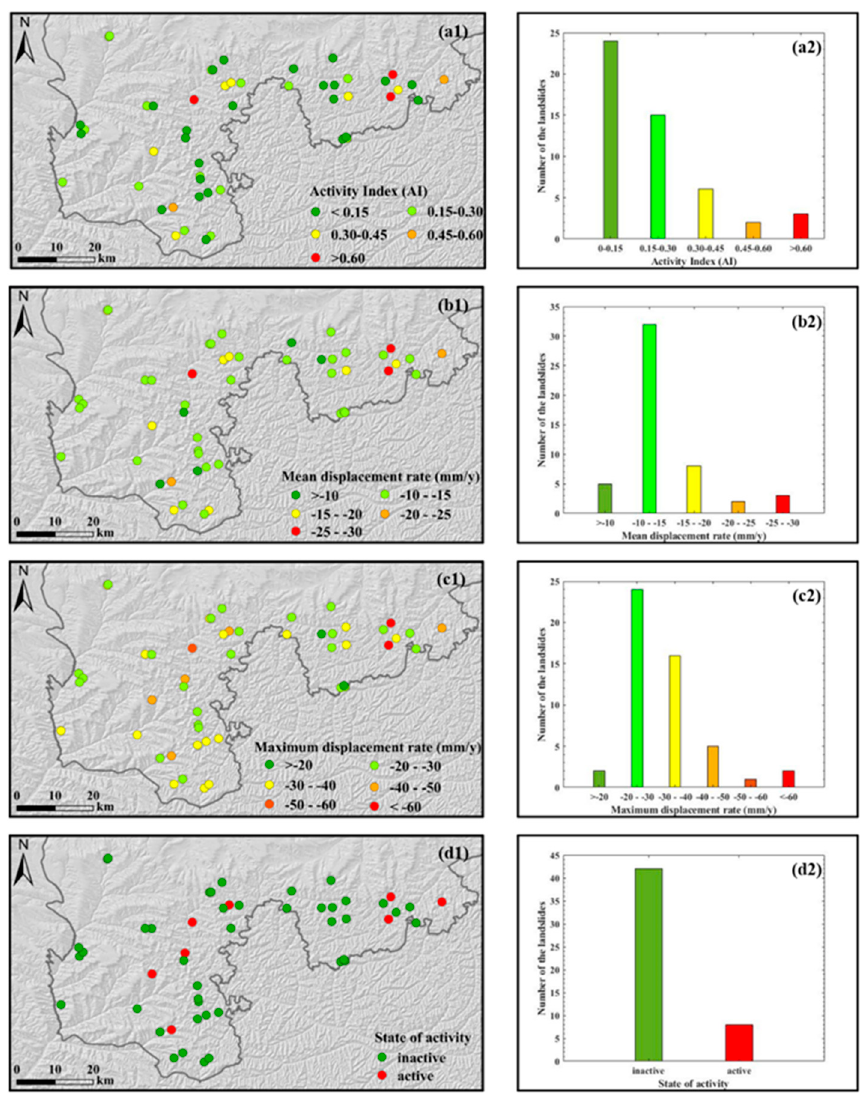
Figure 10. The spatial distribution of all detected loess landslides is classified by ( a1 ) Activity Index (AI); ( b1 ) Mean deformation rate (mm/y); ( c1 ) maximum deformation rate (mm/y) and ( d1 ) the activity degree, which is evaluated by ( a1 , b1 , c1 ). The right column, ( a2 , b2 , c2 , d2 ), represent the frequency distribution of the loess landslides.